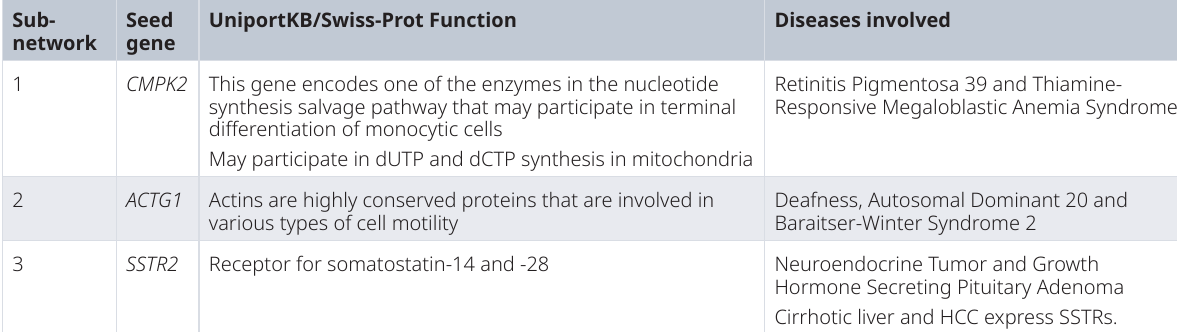
Table 2. Sub-network analysis. Sub-network analysis was performed using the Molecular Complex Detection (MCODE) app from Cytoscape and CMPK2, ACTG1 and SSTR2 emerged as seed nodes among upregulated. Sub- network